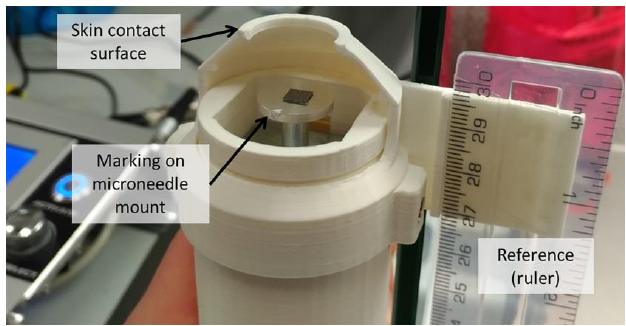
Figure 4. Microneedle applicator used for high-speed imaging.